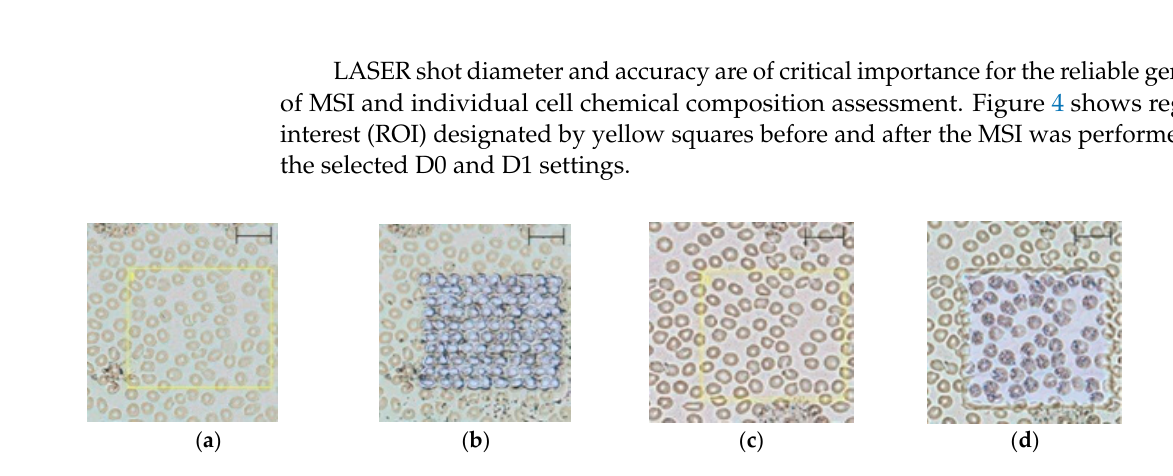
Figure 4. LASER footprint: ( a ) light microscopy image of a blood smear covered by 9AA, ( b ) the same optical field as in 4a after MSI was performed using D0, ( c ) light microscopy image of a blood smear covered by 9AA, and ( d ) the same optical field as in 4c after MSI was performed using D1. Optimized sample preparation and instrumental conditions were used. Scale bar corresponds to 20 μ m.